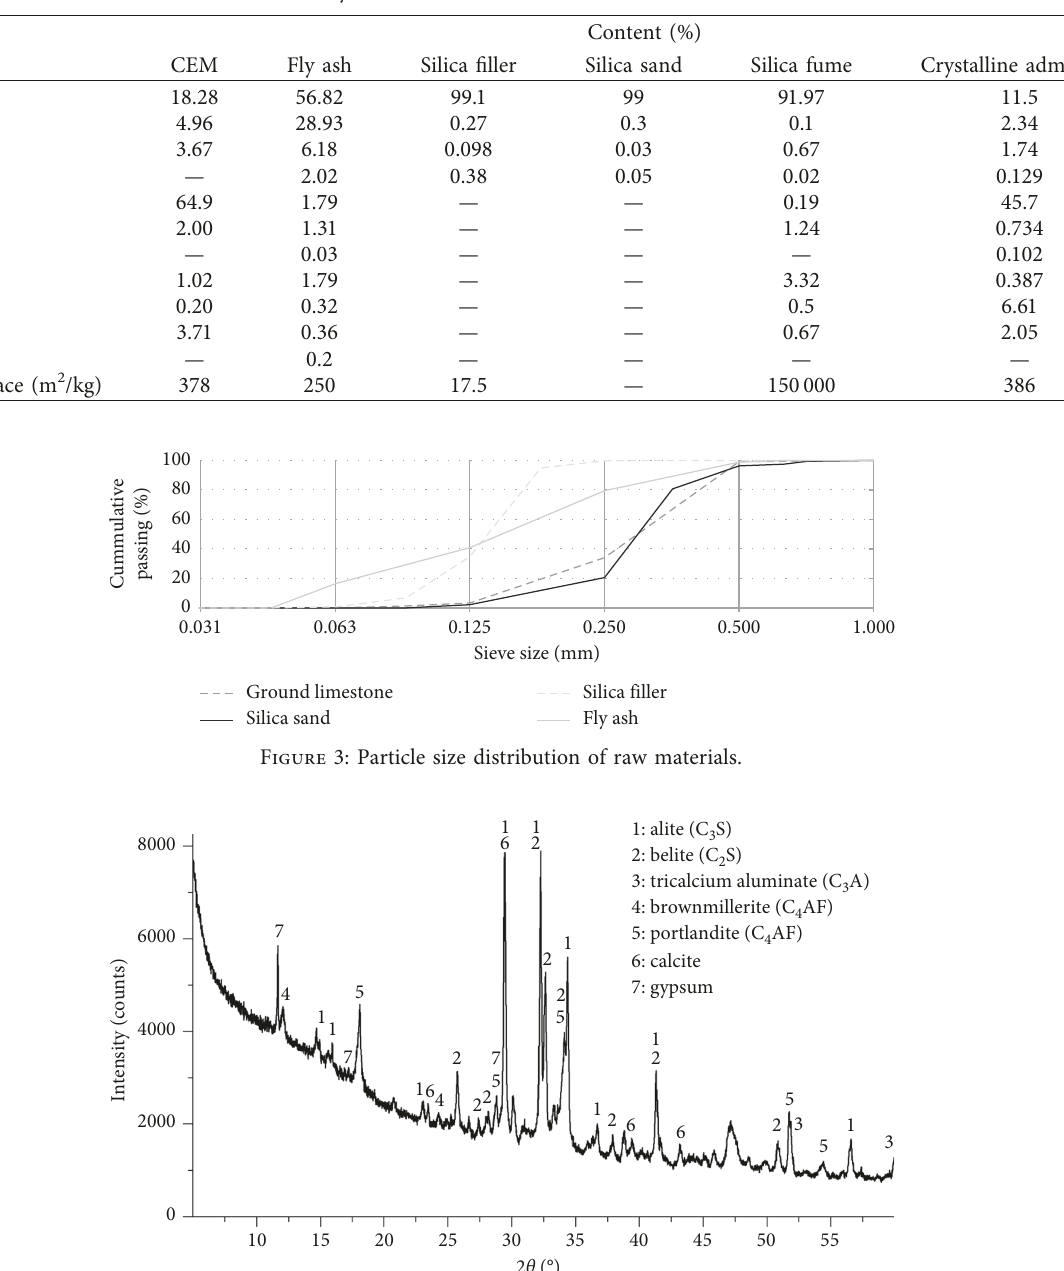
Table 4: Physical and chemical characteristics of materials.